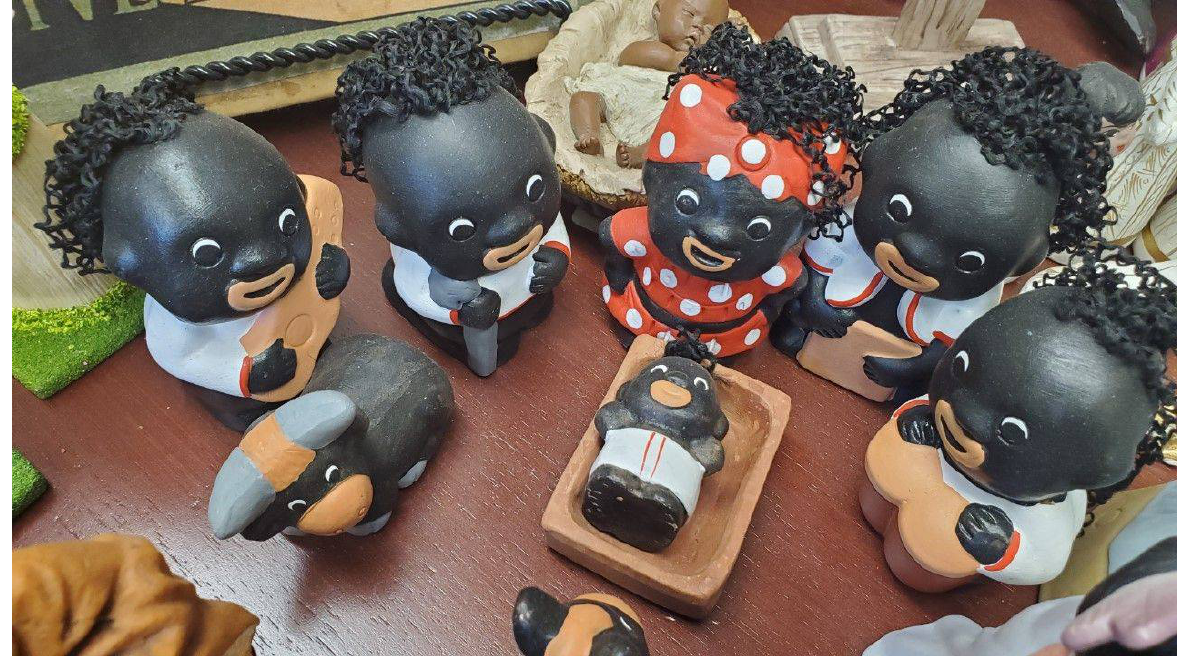
Figure 2. A minstrelsy Nativity scene from my trip to Panama in 2016.